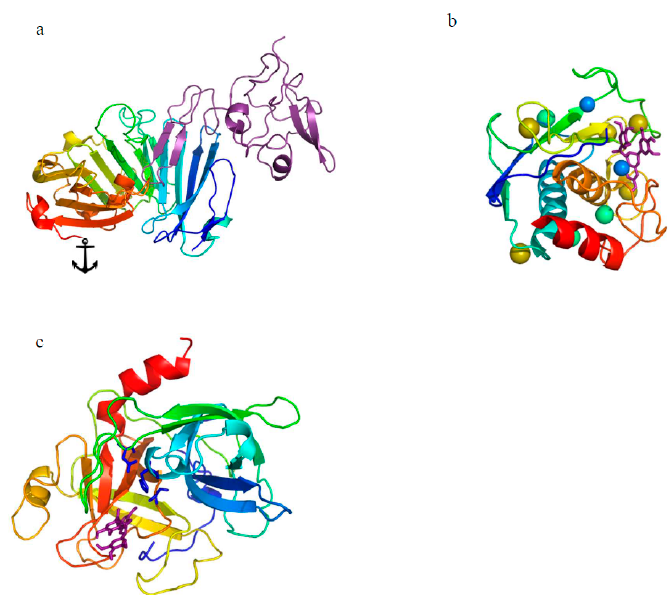
Figure 1. Illustration of proteins. ( a ) amino-terminal fragment of urokinase plasminogen activator (uPA) binds to the central cavity of soluble urokinase-type plasminogen activator receptor (suPAR) shown in purple. uPAR domains (Protein Data Bank entry: 3U73): residues 1–93 domain DI shown in blue–light blue, residues 94–191 domain DII shown in green, yellow–green, residues 192–277 domain DIII shown in light-brown, red; uPAR is attached to the cell surface by a GPI-anchor (glycosylphosphatidylinositolat) of the D-III domain, protein structure (Protein Data Bank entry: 2I9B) [23], ( b ) MMP-9 in complex with epigallocatechin gallate where EGCG is shown in purple as a stick model; ions in MMP-9 are shown as spheres: Zn 2+ in blue, Ca 2+ in yellow, Cl − in green [10], MMP-9 protein structure (Protein Data Bank entry: 2OVX) [24], ( c ) EGCG is shown as a stick model in purple bound to the specificity pocket of urokinase close to the catalytic triad shown as sticks in blue [10]; protein structure (Protein Data Bank entry: 2VNT) [25]. All drawings made using program PyMOL